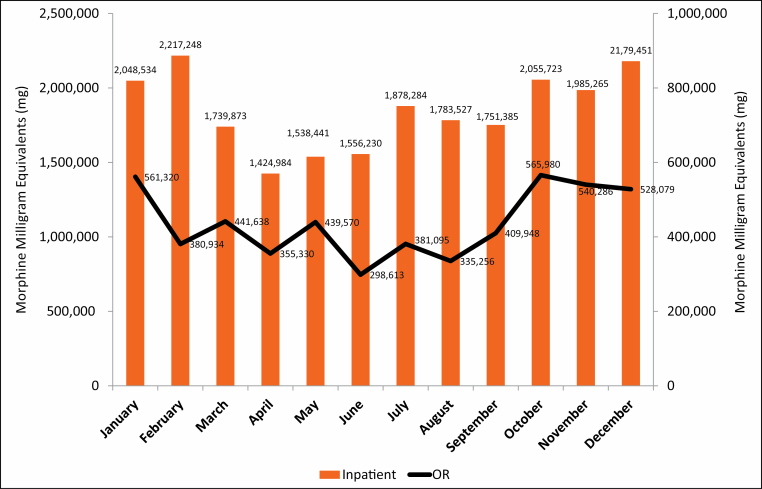
Opioid dispensing for inpatient and operating room (OR) care in 2018